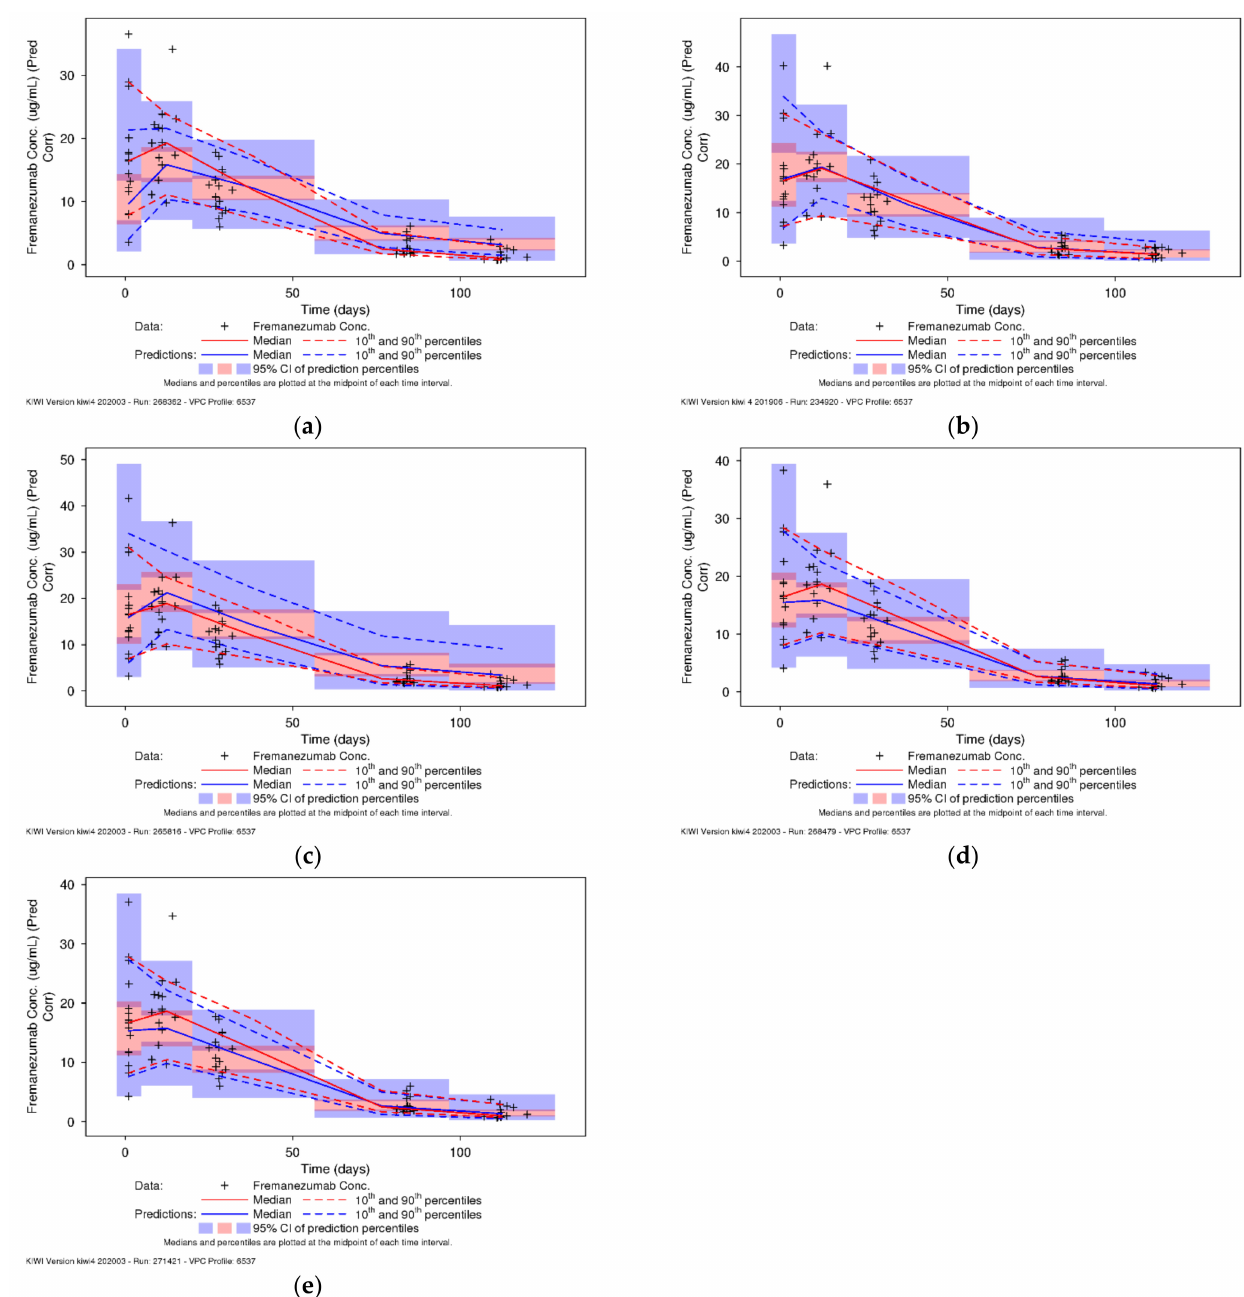
Figure 1. Prediction-corrected visual predictive check plots for pediatric patients ( n = 15): ( a ) applying the previously developed adult population pharmacokinetic model, ( b ) final fremanezumab pediatric population pharmacokinetic model 1 , ( c ) alternative fremanezumab pediatric population pharmacokinetic model with fixed allometric exponents, ( d )